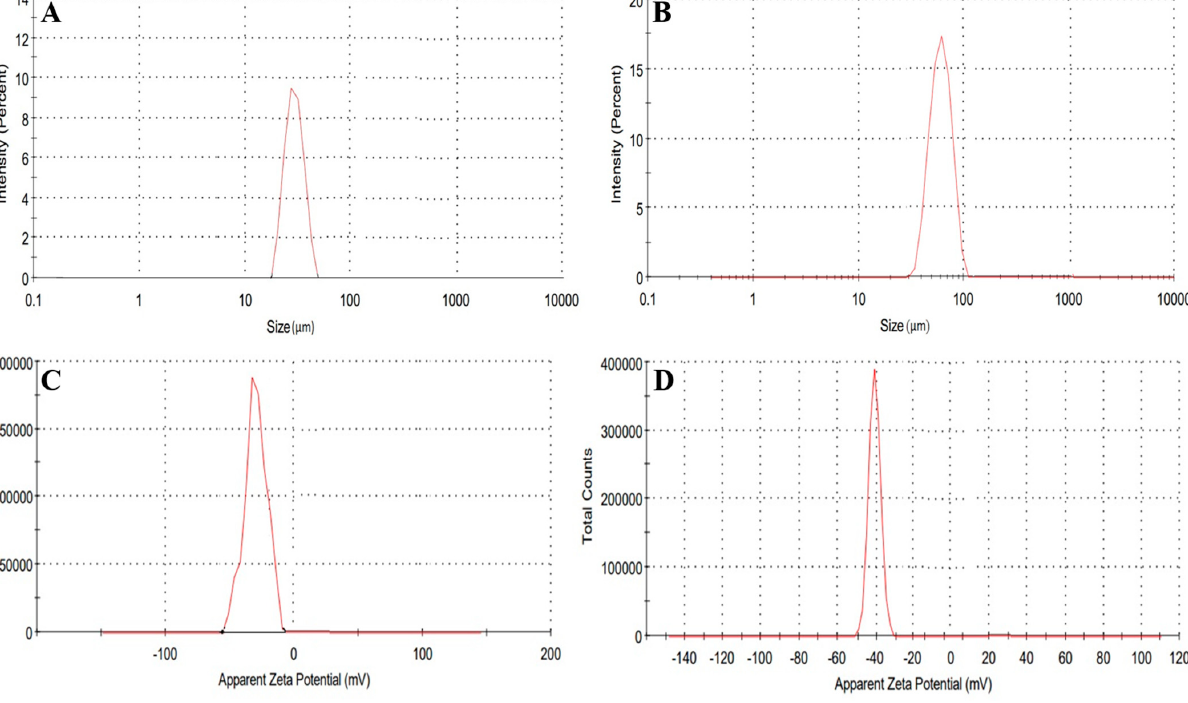
Figure 11. Zeta size of unloaded ( A ) (MCT9) and tofacitinib-loaded hydrogel microparticles (MCT9) ( B ), zeta potential of unloaded ( C ) (MCT9) and loaded MU-CHI-Co-Poly (MAA) hydrogel microparticles ( D ) (MCT9).